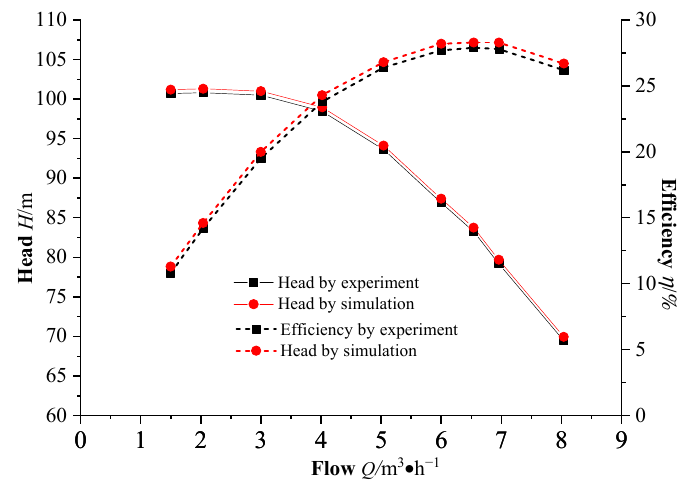
Figure 6. Comparison of External Characteristic